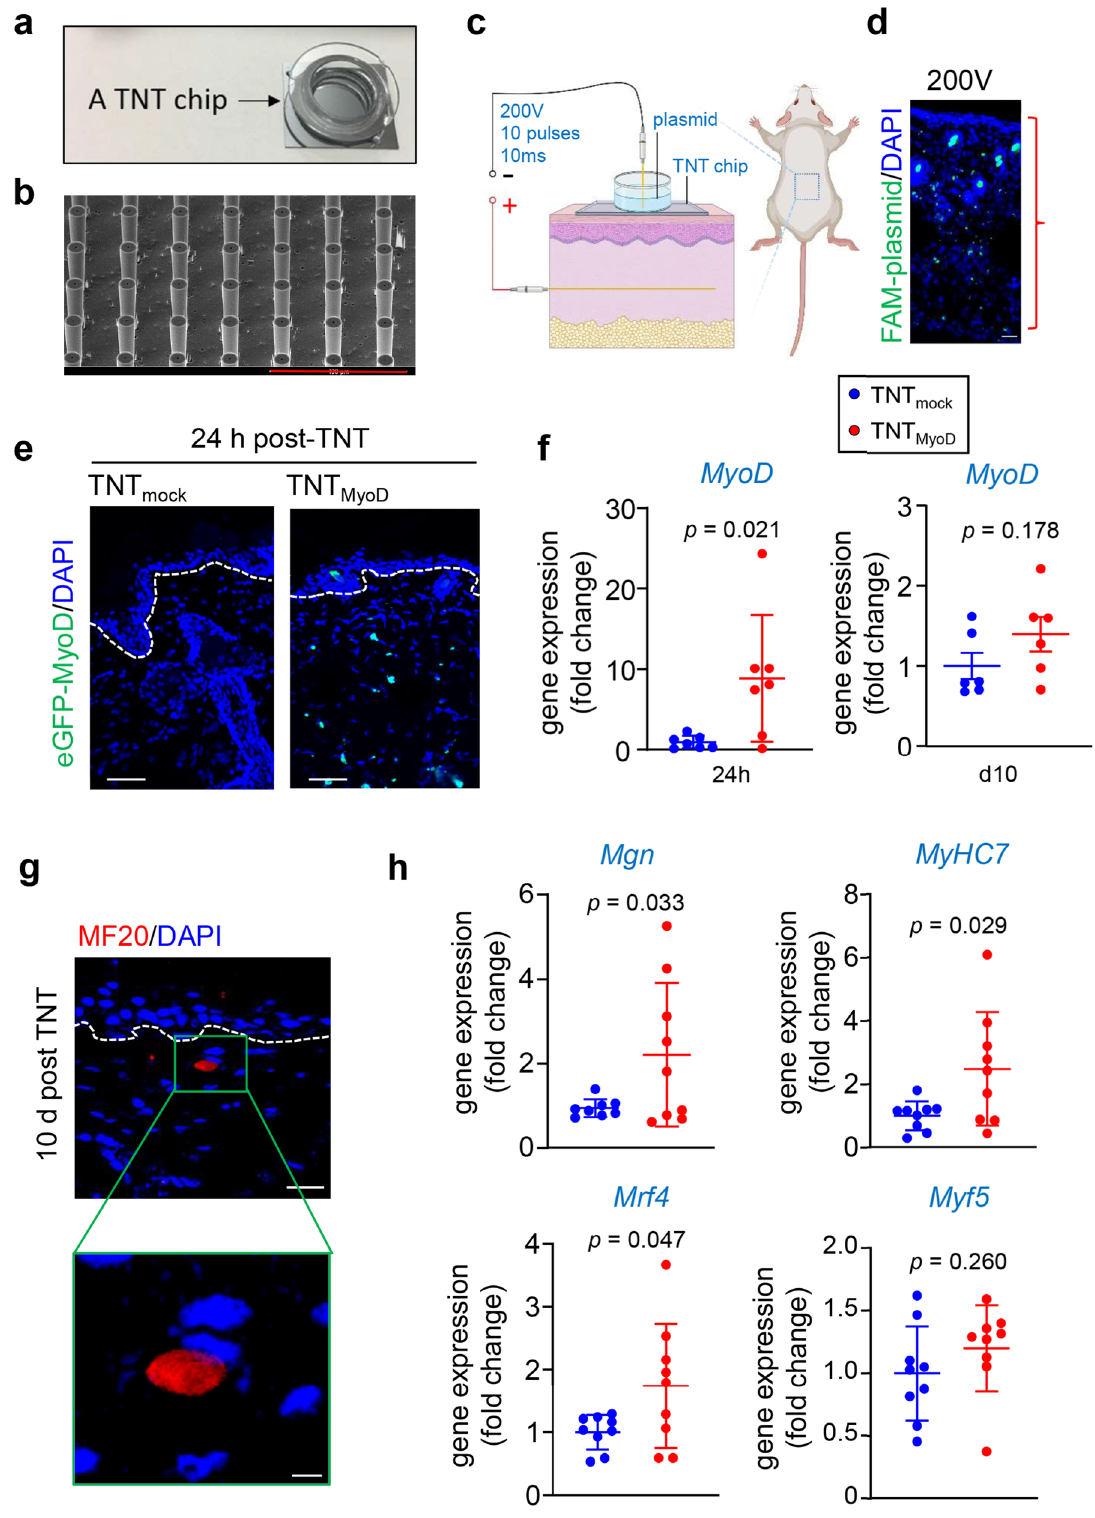
Fig. 1 TNT MyoD transfects deep into the dermis and causes myogenic reprogramming. a Image of TNT 2.0 device. b SEM images of TNT device showing needle array projections. Scale, 400 µm. c Schematic diagram showing TNT set up for skin. d Distribution of FAM-labeled plasmids immediately after TNT using various voltages on mouse dorsal skin. Scale bar = 40µm. e Visualization of eGFP signal 24 h after TNT with the eGFP- MyoD plasmid, showing expression of eGFP in epidermis and dermis. No eGFP fl uorescence was detected in skin transfected with mock plasmids. The white dashed line indicates the dermal-epidermal junction. Scale, 50 µm. f MyoD expression in skin 24 h and day 10 post-TNT ( n = 7,6). g Immuno fl uorescence staining of MF20 (myosin heavy chain) at 10days post-TNT in the dermis. The white dashed line indicates the dermal- epidermal junction. The sections were co-stained with DAPI. Scale bar = 20µm, 5 µm ( h ) transcript abundance of myogenic genes compared to mock-transfected skin ( n = 9). All data are expressed as mean ± SD. Data analyzed by Student ’ s t -test. Figure c was created with